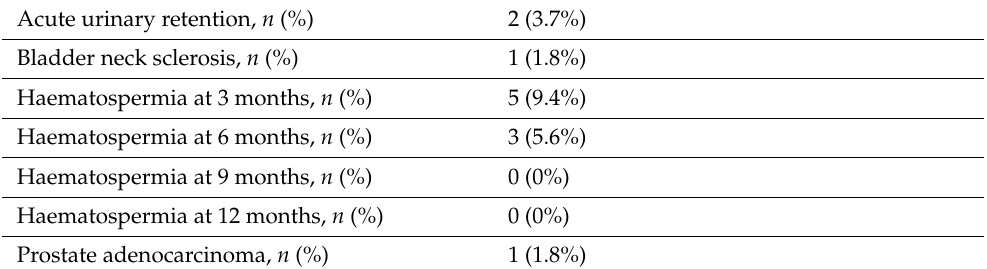
Table 3. Post-operative complications encountered during follow-up.